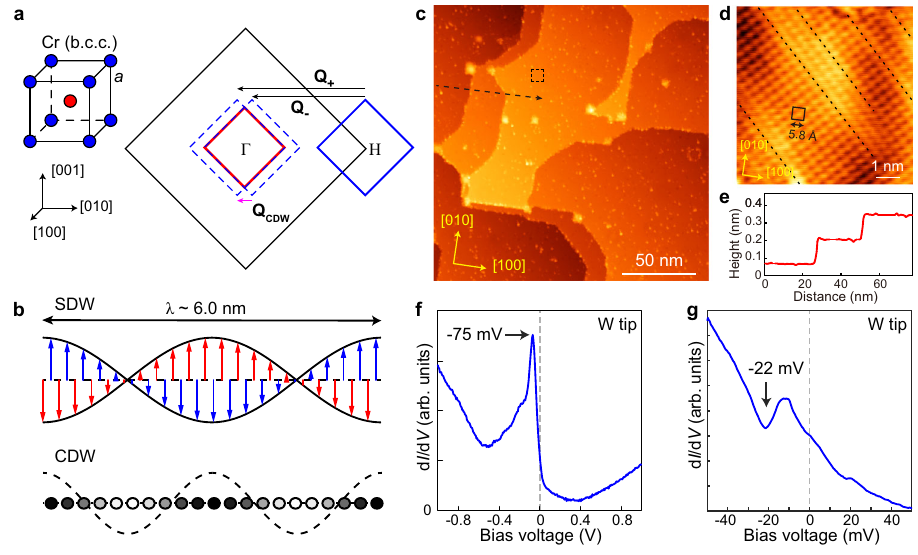
Fig. 1 Sketch of the crystal structure and SDW/CDW states of bulk Cr, and STM characterization of Cr(001) surface. a Left: the body-centered cubic (b.c.c.) structure, and right: the (001) plane Brillouin zone of Cr. Electron and hole Fermi surfaces (cross sections) are represented by red and blue squares, respectively. The nesting vectors Q ± = 2 π / a (1 ± δ ) are indicated by black arrows, and Q CDW = Q + − Q − is the CDW wave vector. b Schematic of incommensurate SDW and CDW of bulk Cr in real space. Blue and red arrows represent the spin of corner and body-center Cr atoms in the b.c.c. lattice at T > T 2 ) of SF , respectively. Solid (hollow) circles represent the locations with the highest (lowest) charge density. c Large scale STM image (190 × 190 nm the cleaned Cr (001) surface. d Atomically resolved STM image (taken in the dashed square in panel c ) showing a centered (2 × 2) structure. The dashed lines indicate the surface line-dislocations (see Supplementary Fig. S1 for more details). e Line pro fi le taken along the dashed line in panel ( c ). f Typi c al d I / d V point spectrum taken on a defect-free region with a normal W tip (setpoint: V b = 1 V, I = 60 pA, Δ V = 20 mV). g Typical d I /d V spectrum taken around E V = 50 mV, I = 100 pA, Δ V = 1 mV), a DOS dip at V ≈ − 22 (±1) mV is F by W tip ( setpoint: b b